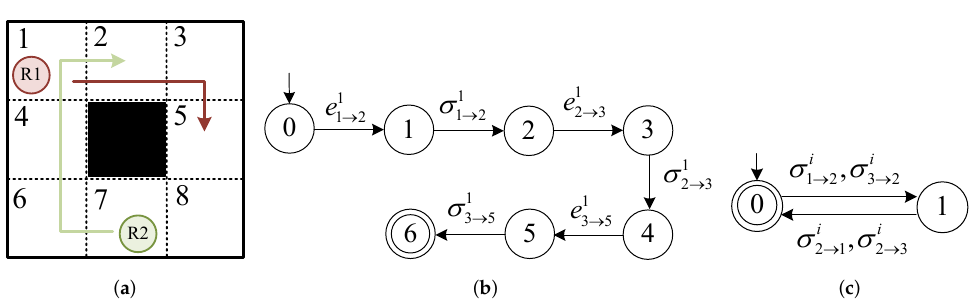
Figure 15. Modeling for warehouse; ( a ) A warehouse; ( b ) Process P 1 for Robot 1; ( c ) Resource R 2 for Position